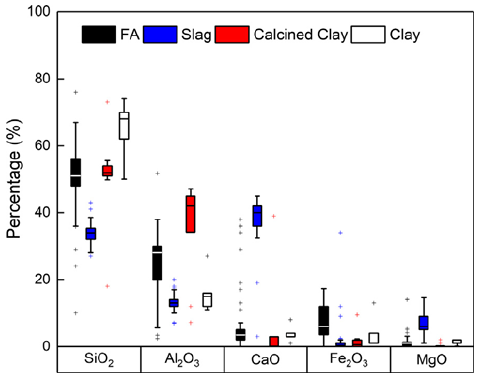
Figure 1. Average chemical composition of all aluminosilicate alkali-activated material (AAM) precursors reviewed in the literatures [12].